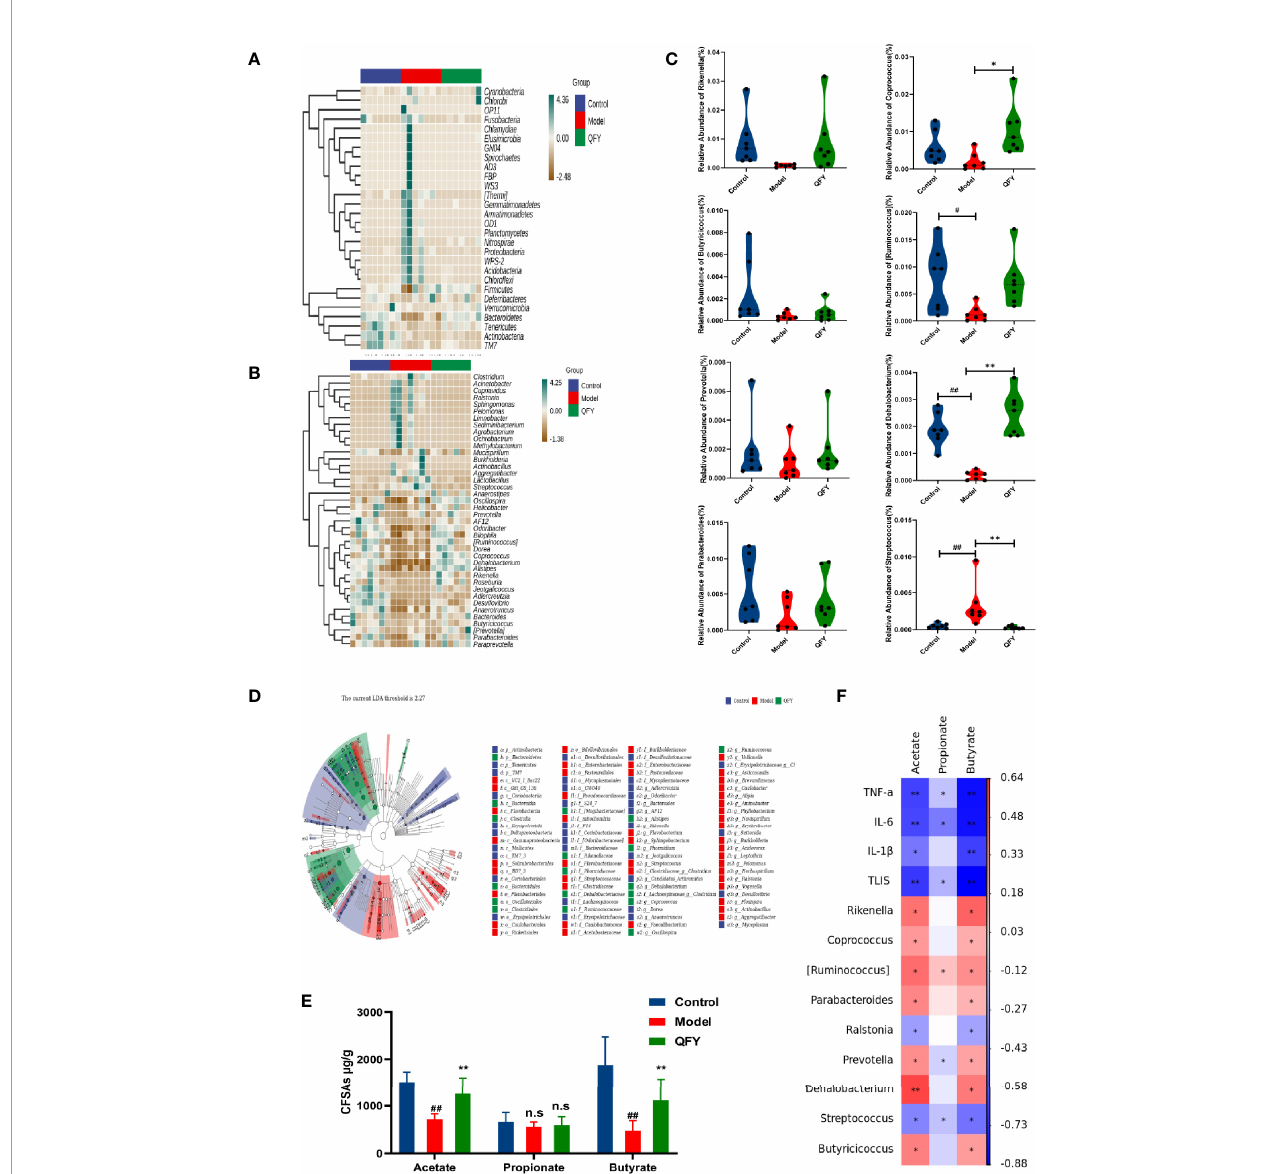
FIGURE 3 | QFY Increased SCFAs and Shaped Mouse Gut Microbial Ecology. Mouse feces of Control, Model, and QFY groups were collected then analyzed to determine microbiota composition. (A) Relative fecal bacterial abundance percentages of the top 40 detected phylum. (B) Relative fecal bacterial abundance percentages of the top 40 detected geneus. (C) Box chart showing signi fi cant relative abundance variations at the genus level. (D) Classi fi cation tree of sample population based on LEfSe analysis, with sizes of nodes re fl ecting relative abundances and different colors corresponding to different taxonomic groups. (E) Levels of SCFAs (acetate, propionate, and butyrate) in mouse feces. (F) Spearman correlation analysis results for SCFAs and gut microbiota. Data are presented as the mean ± SD for each group (n = 7), # p < 0.05, ## p < 0.01 versus Control; * p < 0.05, ** p < 0.01 versus Model; n.s, no signi fi cant